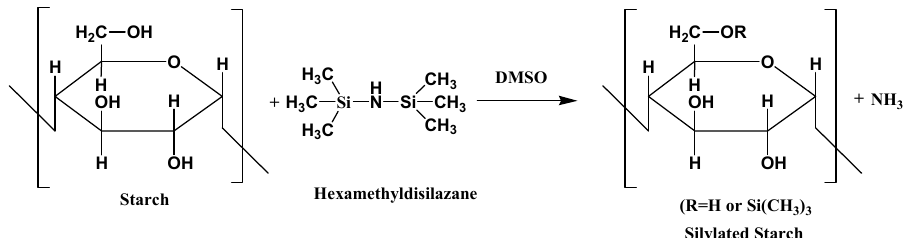
Figure 10. Schematic illustration of the reactions involved in the silylation of starch with hexamethyldisilazane (HMDS). Adapted from [58], with permission from Elsevier and Copyright Clearance Center, 2009.